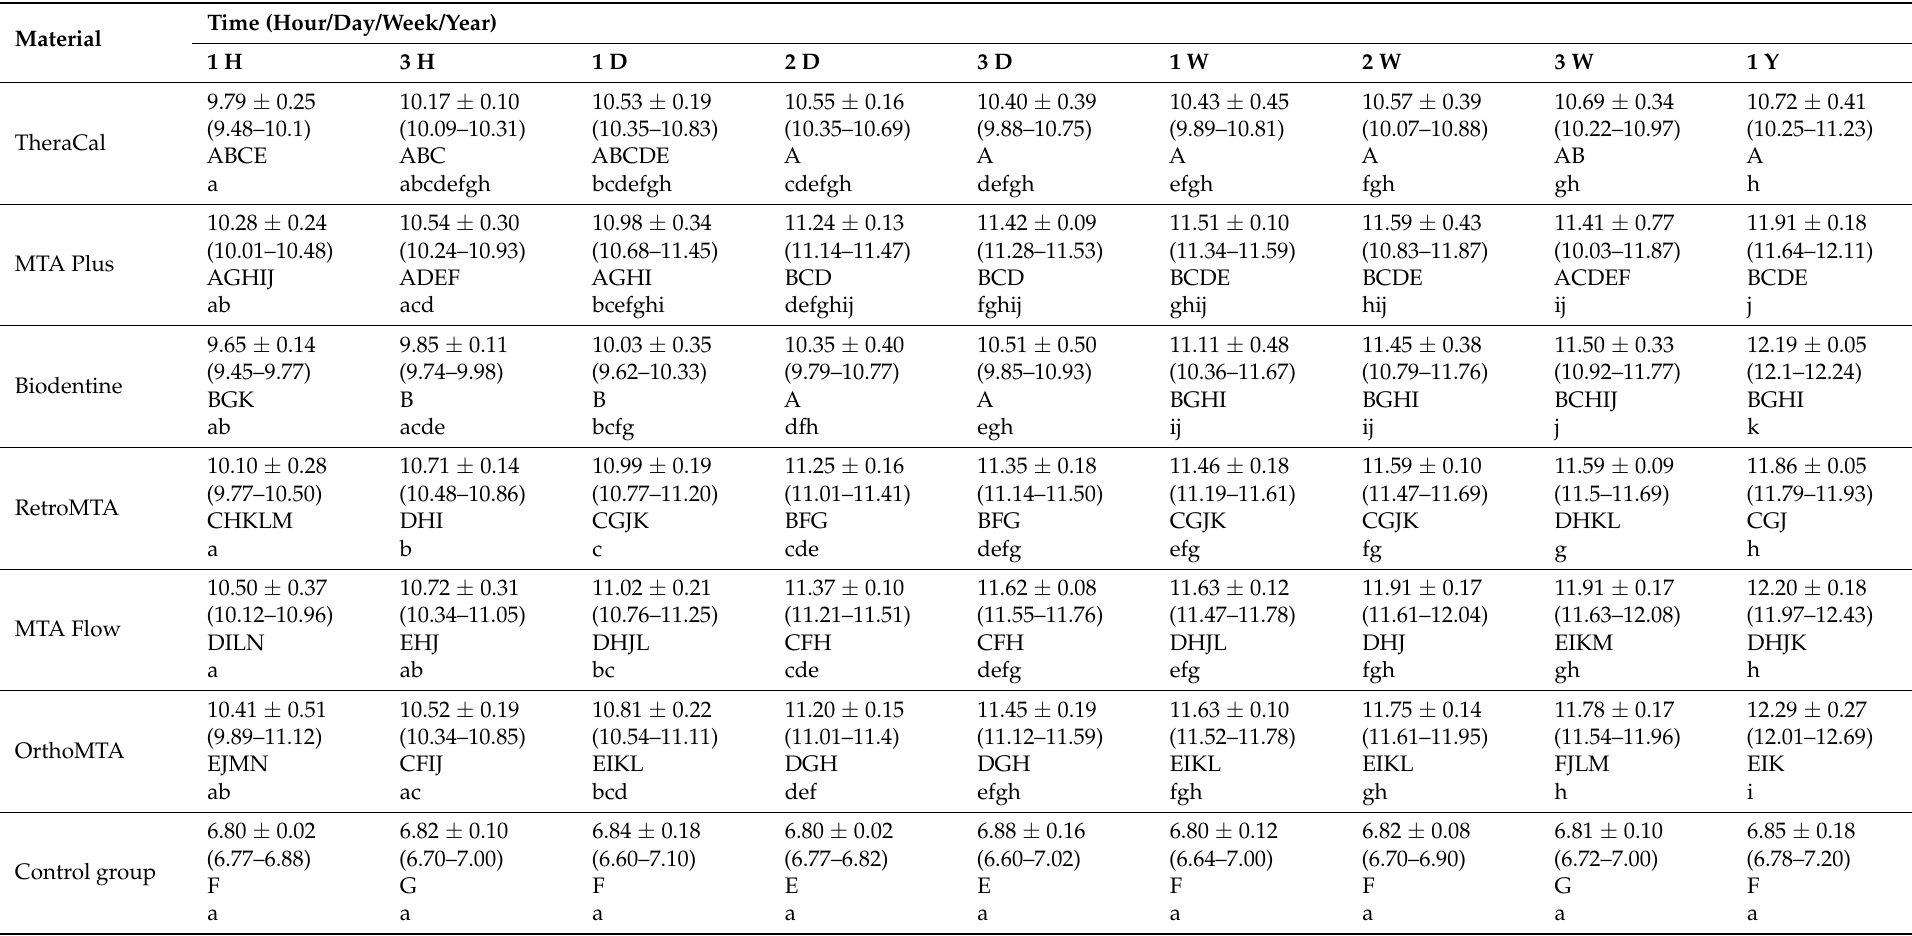
Table 2. pH values recorded at different time periods (mean, SD, and